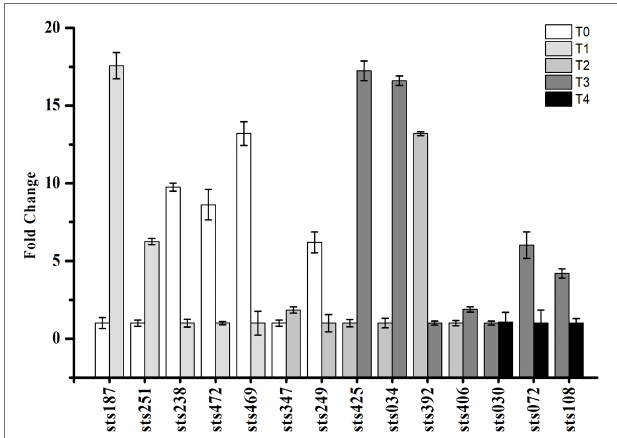
FIGURE 6 | Validation of the expression of selected candidate sRNAs by qRT-PCR. The expression profiles of selected sRNA genes were assessed using the 2 − ( ΔΔ CT) method. T0, T1, T2, T3, and T4 indicate the early-lag, late- lag (early-exponential), mid-exponential, late-exponential, and stationary phases,